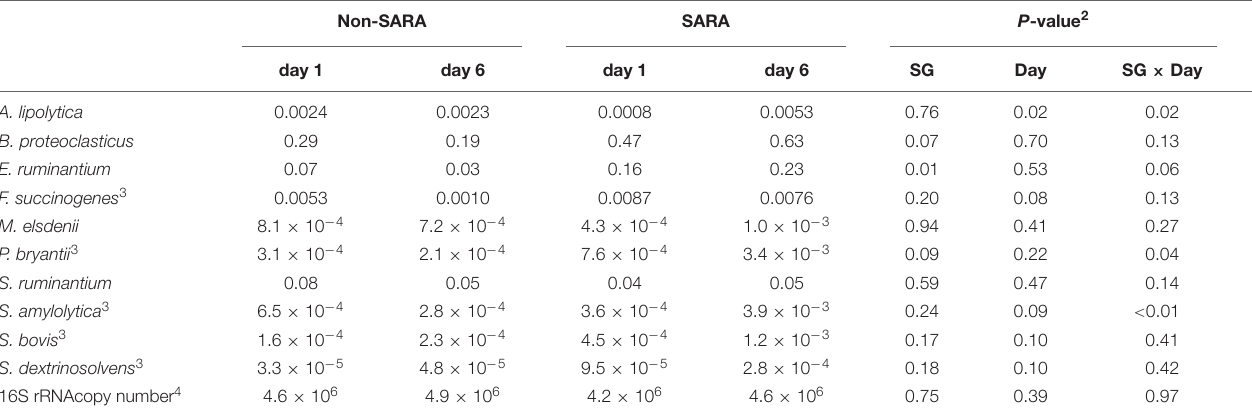
TABLE 2 | Effect of SARA induction on relative abundances of bacterial genera in the solid fraction using qPCR.